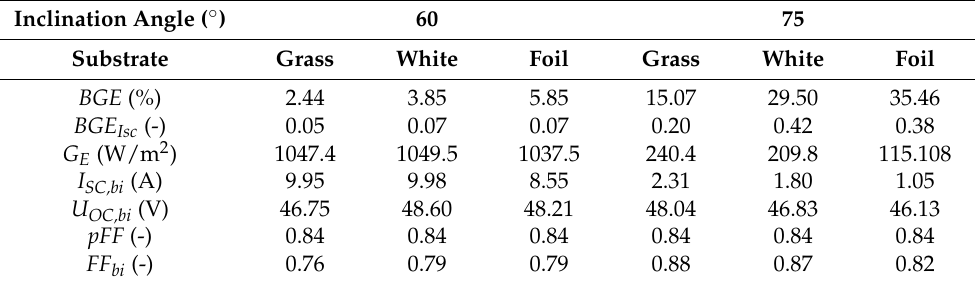
Table 18. A comparison of the calculated parameters for the bifacial module tested in various operating